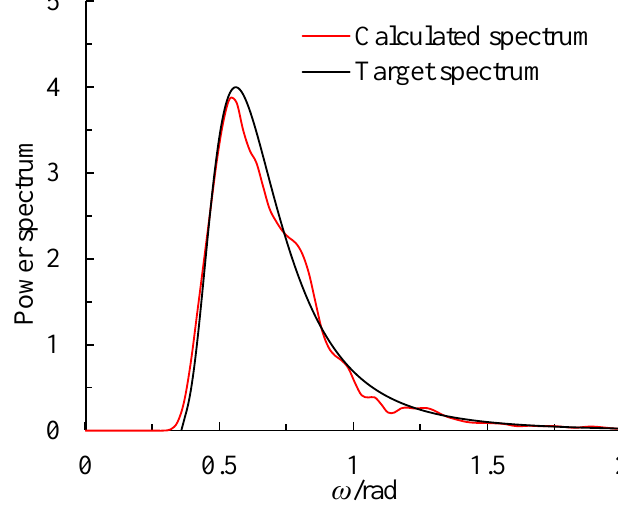
Figure 16. Comparison of the power spectrum of wave load.